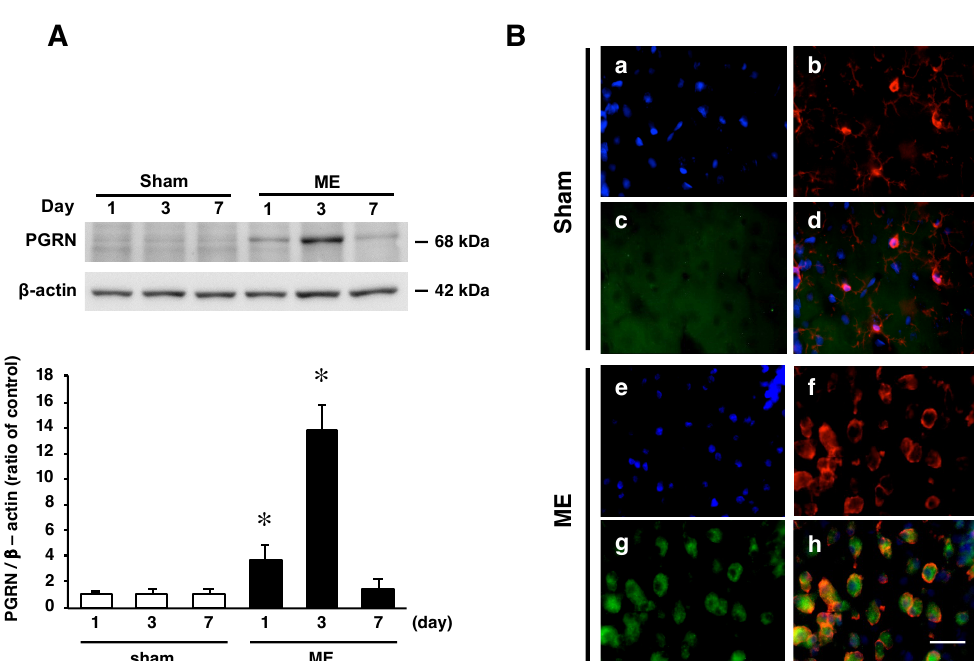
Figure 1. ( A ) Time course of changes in the levels of Progranulin (PGRN) protein in the sham- (sham; white bars) and microsphere-induced cerebral embolism (ME)-operated groups (ME; black bars) on days 1, 3, and 7 after surgery. Bands corresponding to PGRN were scanned, and the scanned bands were normalized by β-actin on the same blot. Results are expressed as the mean ratio of non-operated (control) group ± SD ( n = 9 each). *Significant difference from the sham-operated group ( p < 0.05); ( B ) Cellular localization of PGRN in the cortex of sham-operated (a–d) and ME-operated (e–h) rats on day 3 after surgery. Images of triple staining (merge, d and h) with Hoechst 33342 (blue, a and e), Iba-1 (red, b and f), and PGRN (green, c and g). The scale bar represents 30 µm.